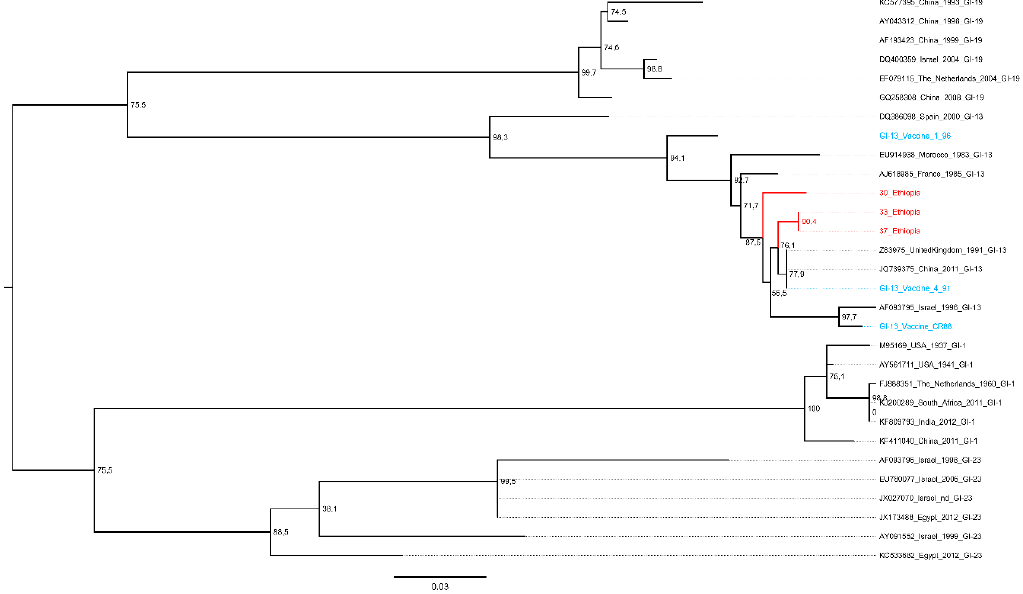
Figure 2. Maximum-likelihood phylogenetic tree comparing the IBV strains obtained in the present study (highlighted in red) with some reference strains proposed by Valastro et al., 2016. Reference vaccine strains are reported in blue. Table 1. Number of pooled samples collected, IBV and aMPV positive, classified according to sample location and production type. Positive (n) Farms Place No. of Pooled Samples IBV aMPV